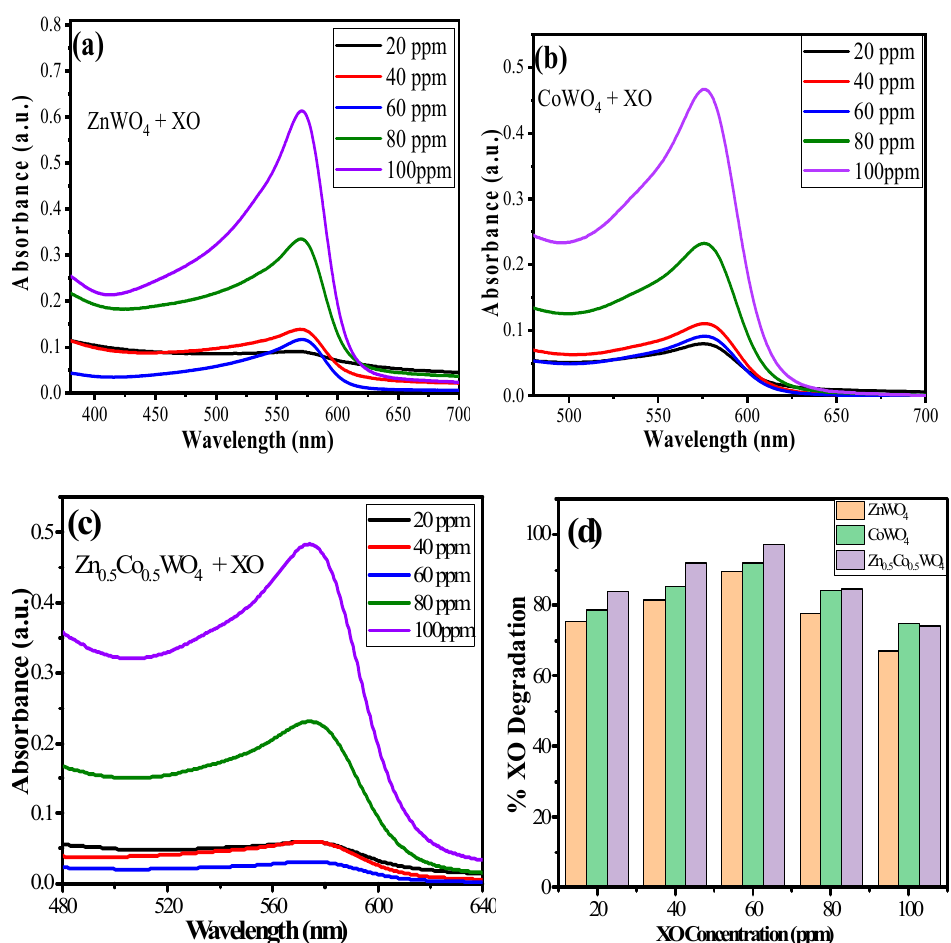
Figure 7. Effect of initial concentration of XO dye on photocatalytic degradation by ( a ) ZnWO 4 ; ( b ) CoWO 4 ; ( c ) Zn 0.5 Co 0.5 WO 4 ; ( d ) XO degradation (%) vs. XO concentration bar graph